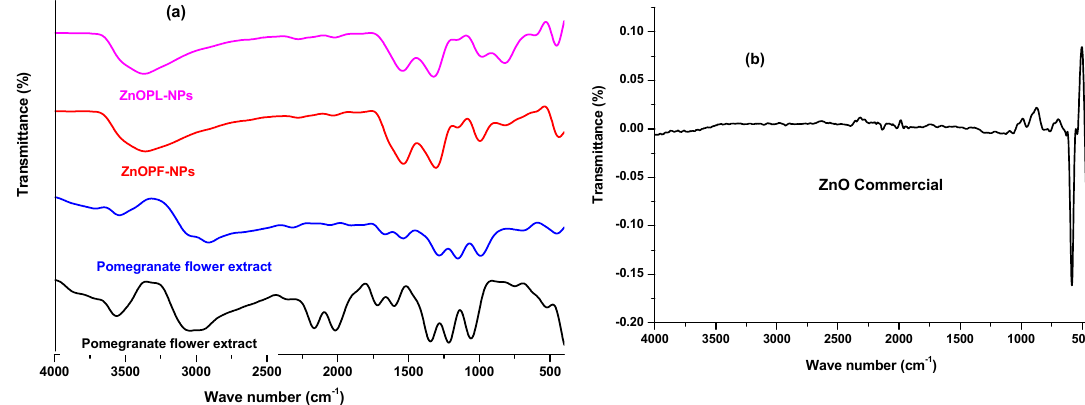
Figure 6. FTIR spectrum for ( a ) pomegranate leaf extract, pomegranate flower extract, pomegranate leaf extract-mediated zinc oxide nanoparticles (ZnO-NPs-PL), pomegranate flower extract-mediated zinc oxide nanoparticles (ZnO-NPs-PF) and ( b ) ZnO commercial sample. Bands for pomegranate flower were obtained at peaks 541, 752, 1053, 1215, 1339, 1613, 1727, 2026,